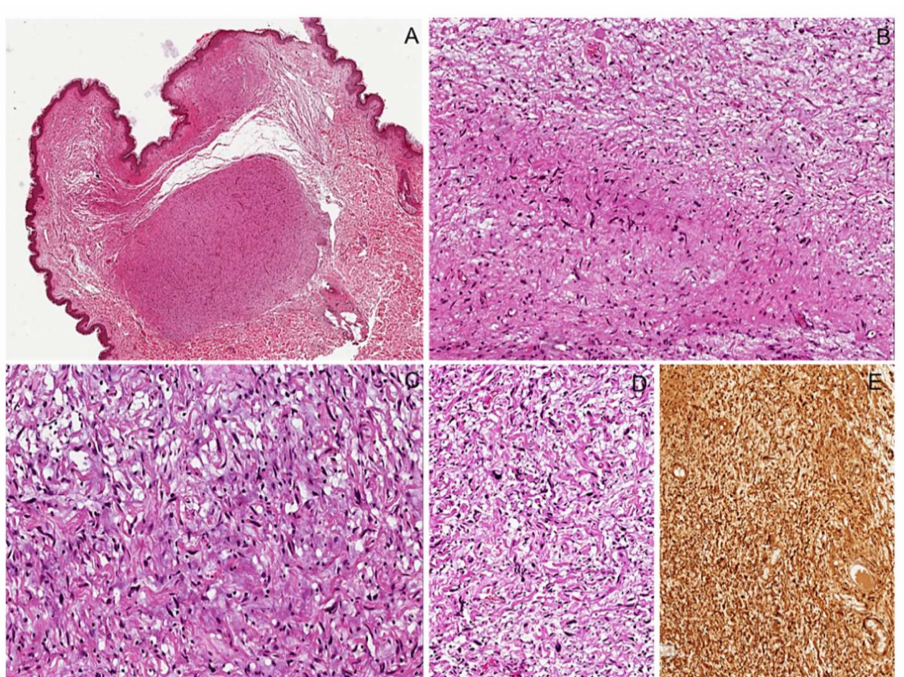
Figure 3. Cutaneous nodular neurofibroma. ( A ) Skin nodule showing a dermal, well-circumscribed, unencapsulated proliferation of spindle cells. ( B ) Neoplastic proliferation showing low to moderate cellularity, in which spindled cells are haphazardly embedded in a fibrillary collagenous stroma. ( C ) Neoplastic cells have hyperchromatic wavy nuclei; wire-like strands of collagen are interspersed among neoplastic cells. ( D ) Mild and focal nuclear atypia can be seen ( E ) Neoplastic cells are diffusely and strongly stained with S100